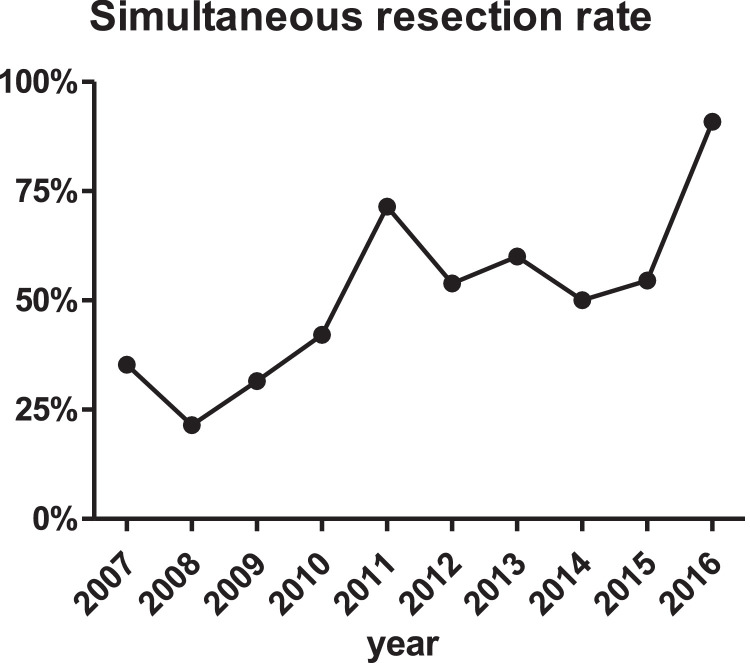
The rate of simultaneous tumor resections (colorectal primary tumor together with liver metastases during one single operation instead of two separate operations) increased from approximately 25% in 2007 to >75% in 2016 (2007: 35%; 2008: 21%; 2009: 32%; 2010: 42%; 2011: 71%; 2012: 54%; 2013: 60%; 2014: 50%; 2015: 55%; 2016: 91%). Clinical characteristics of the patients collective are provided in [1].